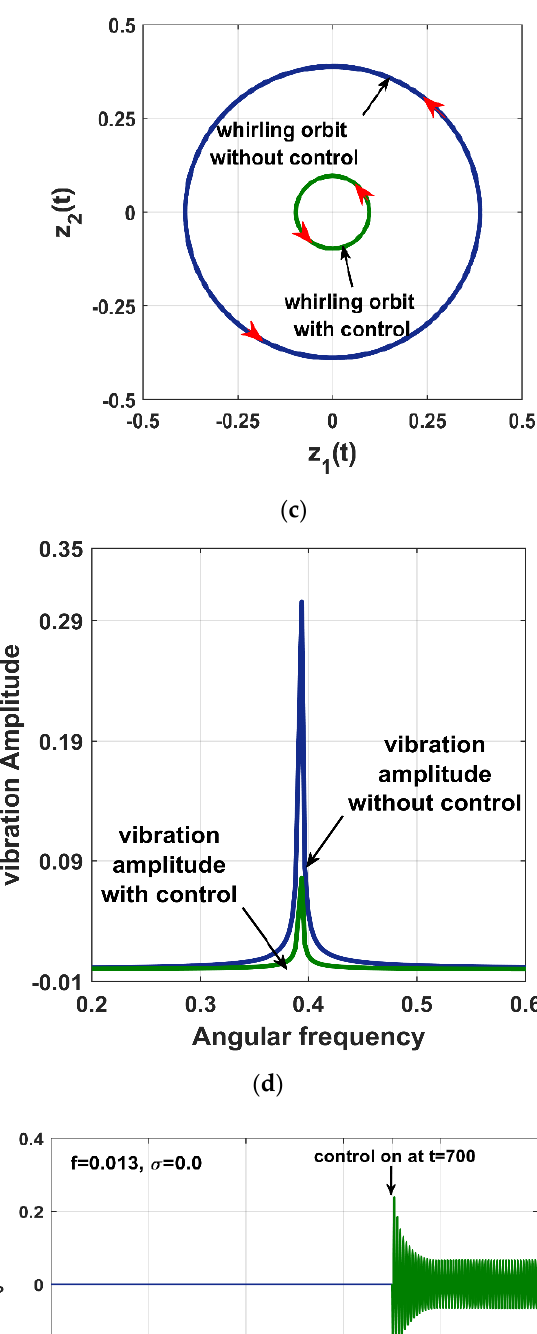
( d ) Figure 14. Vibration amplitudes and phase-angles of the twelve-poles rotor in the case of both the 𝑃𝐷 -control only and the 𝑃𝐷 + 𝐼𝑅𝐶 -control algorithm when 𝑓 = 0.013 : ( a , b ) vibration amplitudes ( 𝑎 (cid:2869) ,𝑎 (cid:2870) ) of the rotor, ( c ) phase angles ( 𝜙 (cid:2869) ,𝜙 (cid:2870) ) when 𝜂 (cid:2869) = 𝜂 (cid:2870) = 𝜂 (cid:2871) = 𝜂 (cid:2872) = 0.0 , and ( d ) phase angles ( 𝜙 (cid:2869) ,𝜙 (cid:2870) ) when 𝜂 (cid:2869) = 𝜂 (cid:2871) = 0.0, 𝜂 (cid:2870) = 𝜂 (cid:2872) = 0.2 . Numerical simulations for the instantaneous lateral vibrations of the rotor system (i.e., 𝑧 (cid:2869) (𝑡) and 𝑧 (cid:2870) (𝑡) ) and the IRC -control algorithm (i.e., 𝑧 (cid:2873) (𝑡) and 𝑧 (cid:2874) (𝑡) ) are illustrated in Figures 15 and 16, according to Figure 14 when 𝜎 = 0.0 and 𝜎 = 0.1 , respectively. The two figures were obtained via solving Equations (19), (20), (23), and (24) using ODE45 MATLAB solver on the time interval 0 ≤ 𝑡 < 700 and deactivating the 𝐼𝑅𝐶 -control algo- rithm (i.e., when 𝜂 (cid:2870) = 𝜂 (cid:2872) = 𝜂 (cid:2875) = 𝜂 (cid:2876) = 0 ), while at 𝑡 = 700 the 𝐼𝑅𝐶 controller was turned on by setting 𝜂 (cid:2870) = 𝜂 (cid:2872) = 0.2, 𝜂 (cid:2875) = 𝜂 (cid:2876) = 1 on the interval 700 ≤ 𝑡 ≤ 1000 . One can note from Figure 15 that the strong instantaneous vibrations of the system (i.e., 𝑧 (cid:2869) (𝑡) and 𝑧 (𝑡) ) in the case of the 𝑃𝐷 -control technique at 𝜎 = 0 was reduced to small values (but (cid:2870) not close to zero) when the 𝐼𝑅𝐶 -control algorithm was turned on at 𝑡 = 700 and the rotor vibration energy was partially transferred to the 𝐼𝑅𝐶 controller. On the other hand, Fig- ure 16 shows that the 𝐼𝑅𝐶 -control algorithm also reduced the rotor vibrations to a small value when 𝜎 = 0.1 rather than pumping more excess energy to the system, as in the case of the 𝑃𝐷 + 𝑃𝑃𝐹 -control technique (see Figure 13).